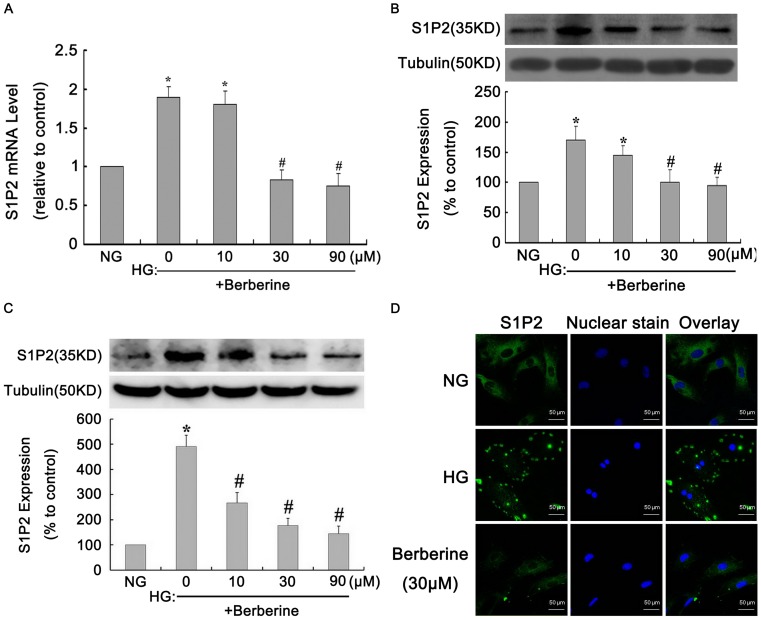
Effects of BBR on S1P2 receptor expression in GMCs under HG condition.GMCs were treated with different dose of BBR under HG condition. After 24 h of incubation, the levels of mRNA (A) and protein (B) of S1P2 receptor were evaluated using real-time PCR and Western blot, respectively. Expression (C) and distribution (D) of S1P2 receptor on the membrane of GMCs was detected by Western blot and LSCM. Data are represented as Means ± SDs, *P<0.05 vs. normal glucose (NG), #P<0.05 vs. HG.